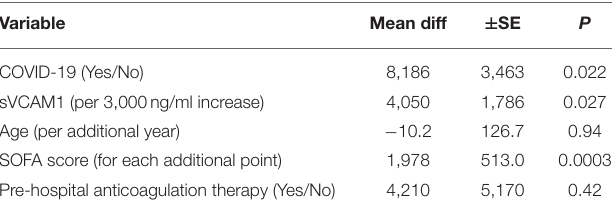
FIGURE 2 | Two-dimensional score plot of principal component analysis according to pneumonia etiology (Lymphonie study 2018–2020). Principal component analysis (PCA) was used to identify potentially significant patterns of 30 variables: 13 plasma biomarkers of coagulopathy and 17 clinical and biological variables from 63 patients with severe pneumonia [non-COVID-19 ( n = 36), COVID-19 ( n = 27)]. Factors 1 and 3 were used to build a two-dimensional score plot of PCA. There is a clear separation between COVID-19 patients (red circles) and non-COVID-19 patients: bacterial (blue triangles), mixed (blue diamonds), viral (gray crosses) and other non-documented severe community acquired pneumonia (gray Xs). Bacterial and mixed severe pneumonia were represented by a high factor 1, while COVID-19 patients had a high factor 3 (LYMPHONIE study, 2018-2020). TABLE 2 | Multivariable linear regression factors associated with duration of mechanical ventilation (variation in minutes) in the first 30 days of hospitalization among 63 patients with severe pneumonia (R ² = 41.3%) (LYMPHONIE study,